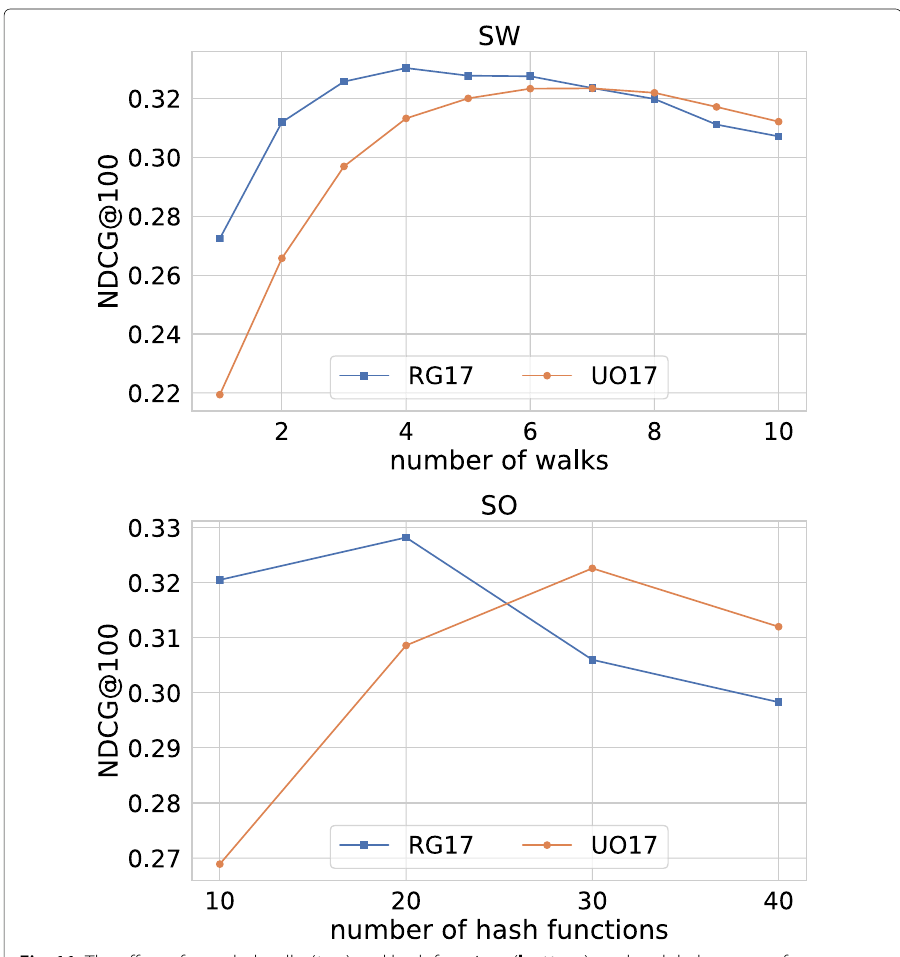
Fig. 11 The effect of sampled walks ( top ) and hash functions ( bottom ) on the global mean performance (NDCG@100) for SW and SO respectively. These parameters control the number of sampled node pairs we feed to online Word2Vec at every edge arrival